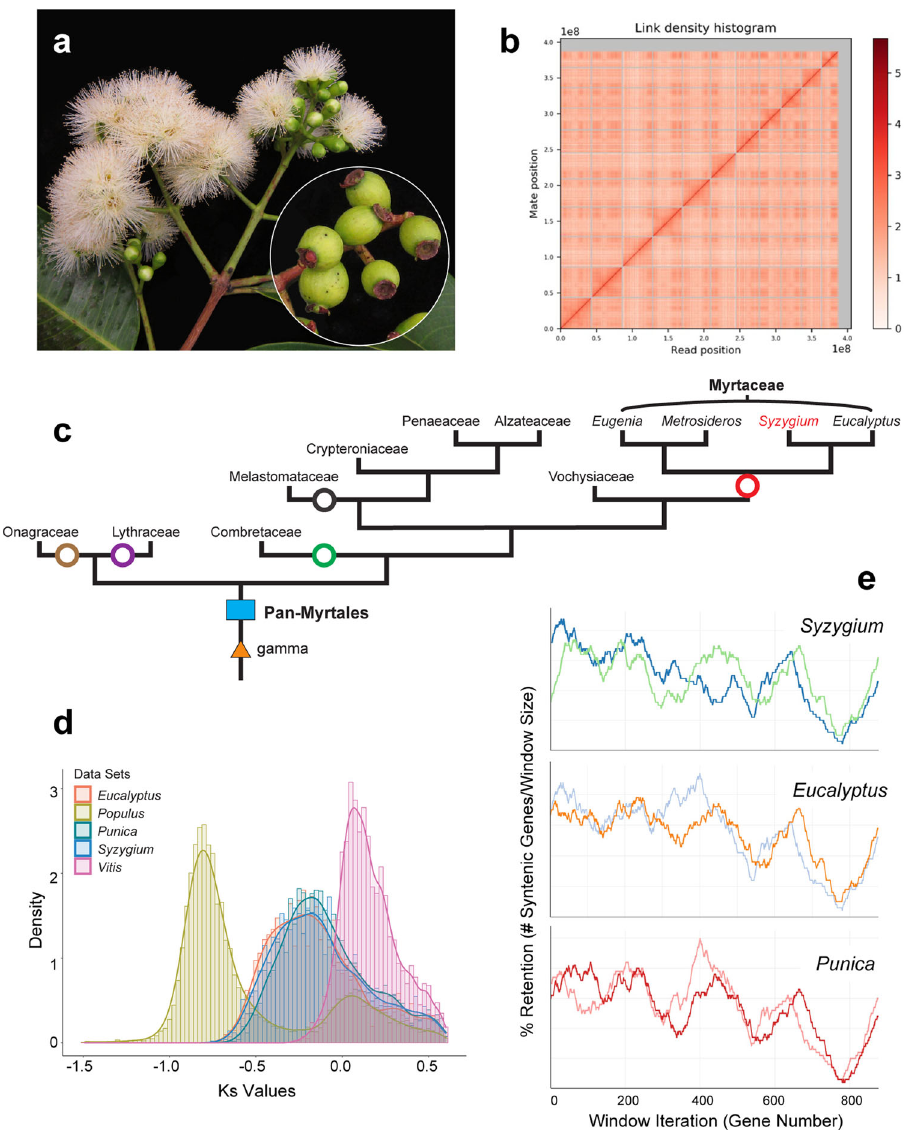
Fig. 1 | Assembly and structural evolution of the Syzygium grande reference genome.a S.grande in fl orescence, fl owersandfruits;thelatterevokethecommon name “ sea apple ” ; b HiC contact map for the scaffolded genome, showing 11 assembled chromosomes; c Phylogeny of major lineages of Myrtales, following Maurin et al. 44 . Genera of Myrtaceae used in genome structural and phylogenetic analyses are also depicted. Punica (Lythraceae) was also examined for structural evolution. Open circles represent the multiple, independent polyploidy events predictedbythe1KPstudy 42 ;ourresultsheresuggestinsteadasinglePan-Myrtales whole genome duplication (blue rectangle) which followed the gamma hexaploidy (orange triangle) present in all core eudicots. d Synonymous substitution rate density plots for internal polyploid paralogs within Syzygium , Eucalyptus , Punica,